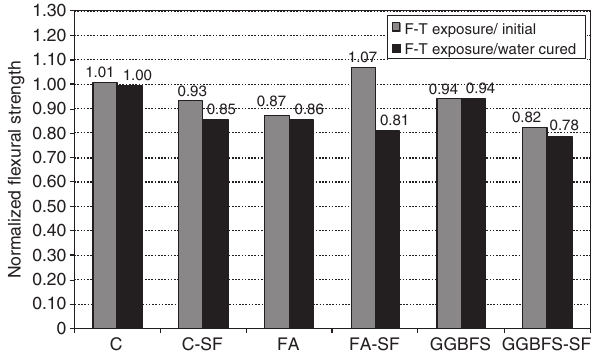
Figure 8 Normalized flexural strength after F-T exposure compared to the initial and water-cured strength.